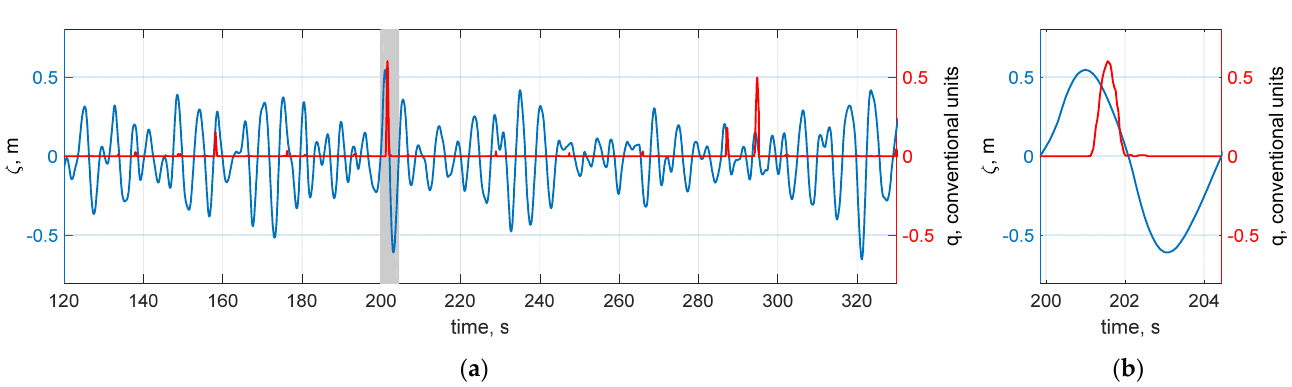
ζ Figure 3. An example of time-series ( a ) of wave elevation, (blue), and whitecap coverage, q , (red), and ( b ) zoomed Figure 3. An example of time-series ( a ) of wave elevation, ζ (blue), and whitecap coverage, q , (red), and ( b ) zoomed individual wave period corresponding to the grey-marked part of the recording. individual wave period corresponding to the grey-marked part of the